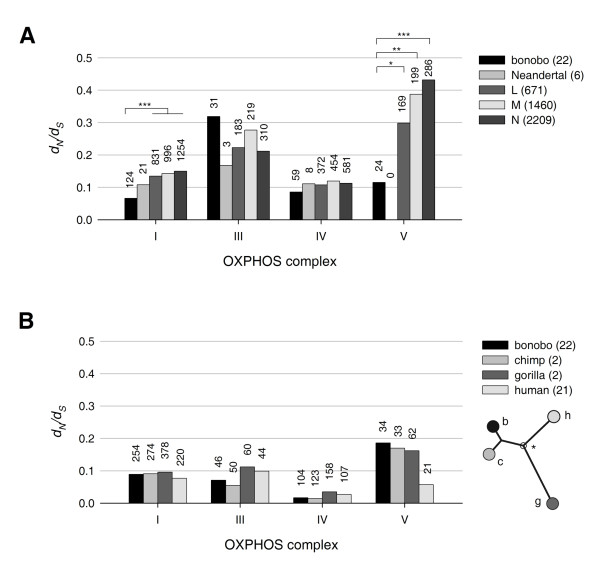
Ratios of non-synonymous to synonymous mutations in mitochondrial protein coding genes. The mitochondrial genes were pooled according to oxidative phosphorylation (OXPHOS) complexes: complex I (MT-ND1, MT-ND2, MT-ND3, MT-ND4L, MT-ND4, MT-ND5, MT-ND6), complex III (MT-CYB), complex IV (MT-CO1, MT-CO2, MT-CO3), and complex V (MT-ATP8, MT-ATP6). Numbers of individuals are shown in brackets; numbers above the bars indicate the total number of polymorphic position for the specific group of protein coding genes. (A) dN/dS ratios of within-group polymorphic sites in Pan paniscus and diverse human haplogroups, including Neandertals. Note that dN/dS ratio of within-species polymorphisms is also referred to as θN/θS in other studies. Statistical significance is indicated by stars (*, P < 0.05; **, P < 0.01; ***, P < 0.005) (B) dN/dS ratios of stable species-specific mutations in gorillas, chimpanzees, bonobos, and 21 human sequences representing all major haplogroups. The scheme on the left shows an unrooted tree of hominids. Filled circles represent species; nucleotide differences were calculated from the theoretical branching point indicated by star.